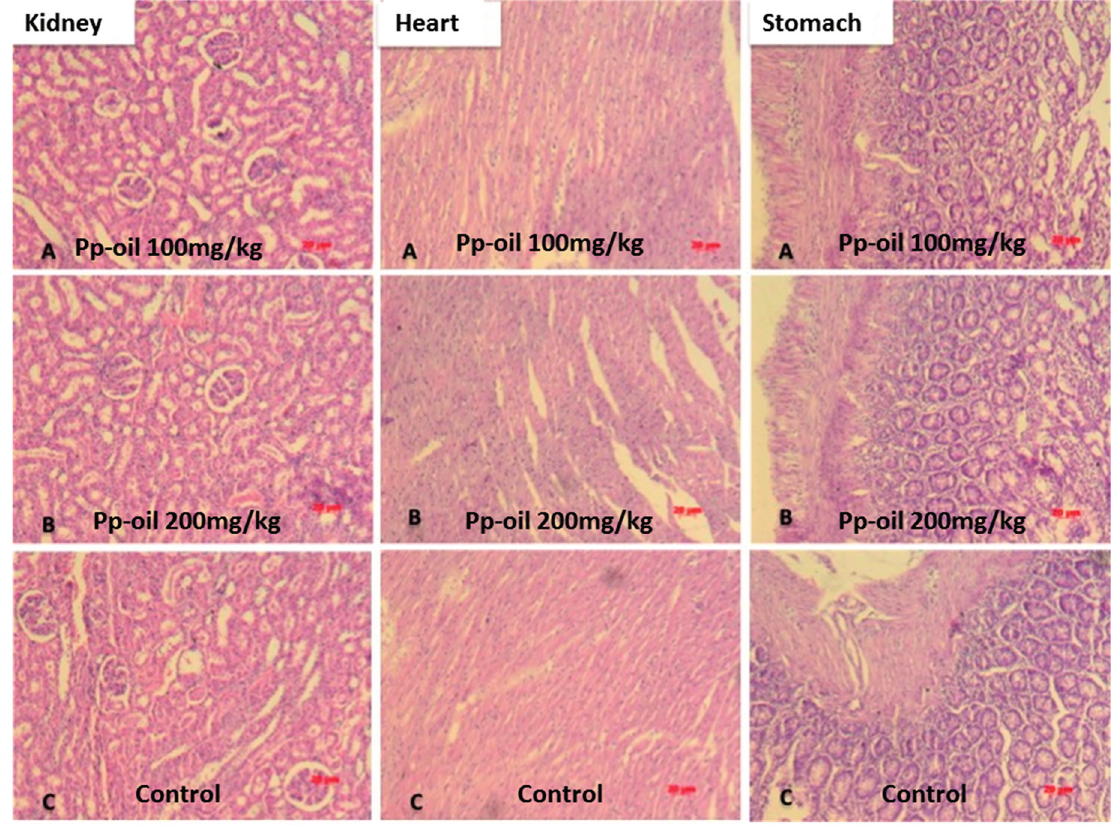
Figure 3. Histopathology of kidney, heart and stomach: ( A ) 100 mg/kg; ( B ) 200 mg/kg and ( C ) control. Dark bar: 20 μ m.